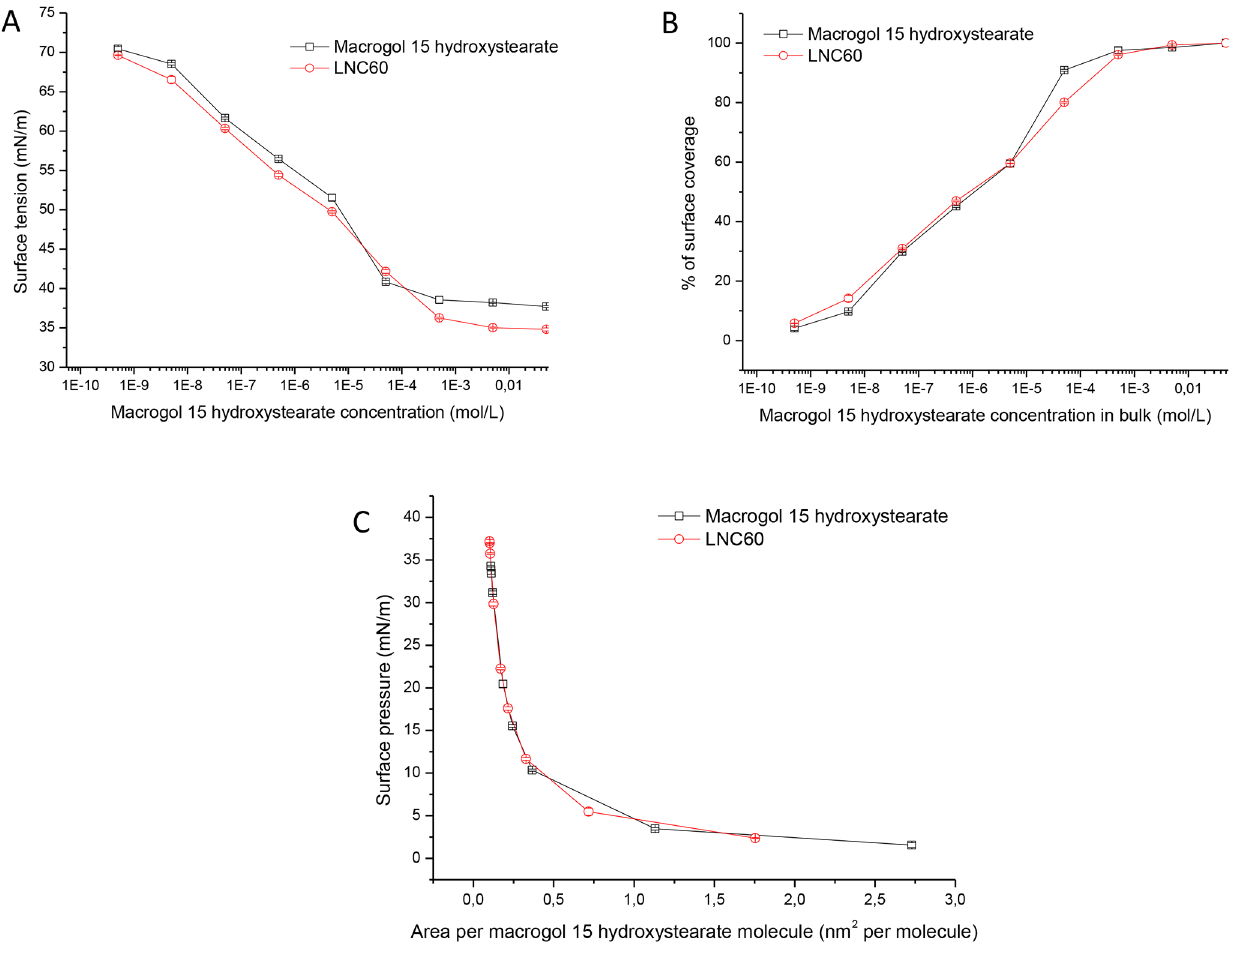
Fig 1. Surface tension as a function of the MHS concentration (A) surface coveragepercentageas a function of MHS concentration, (B) surface pressureversus area per MHS moleculeand (C) the MHS solution and LNC dispersionas determinedby drop tensiometry.